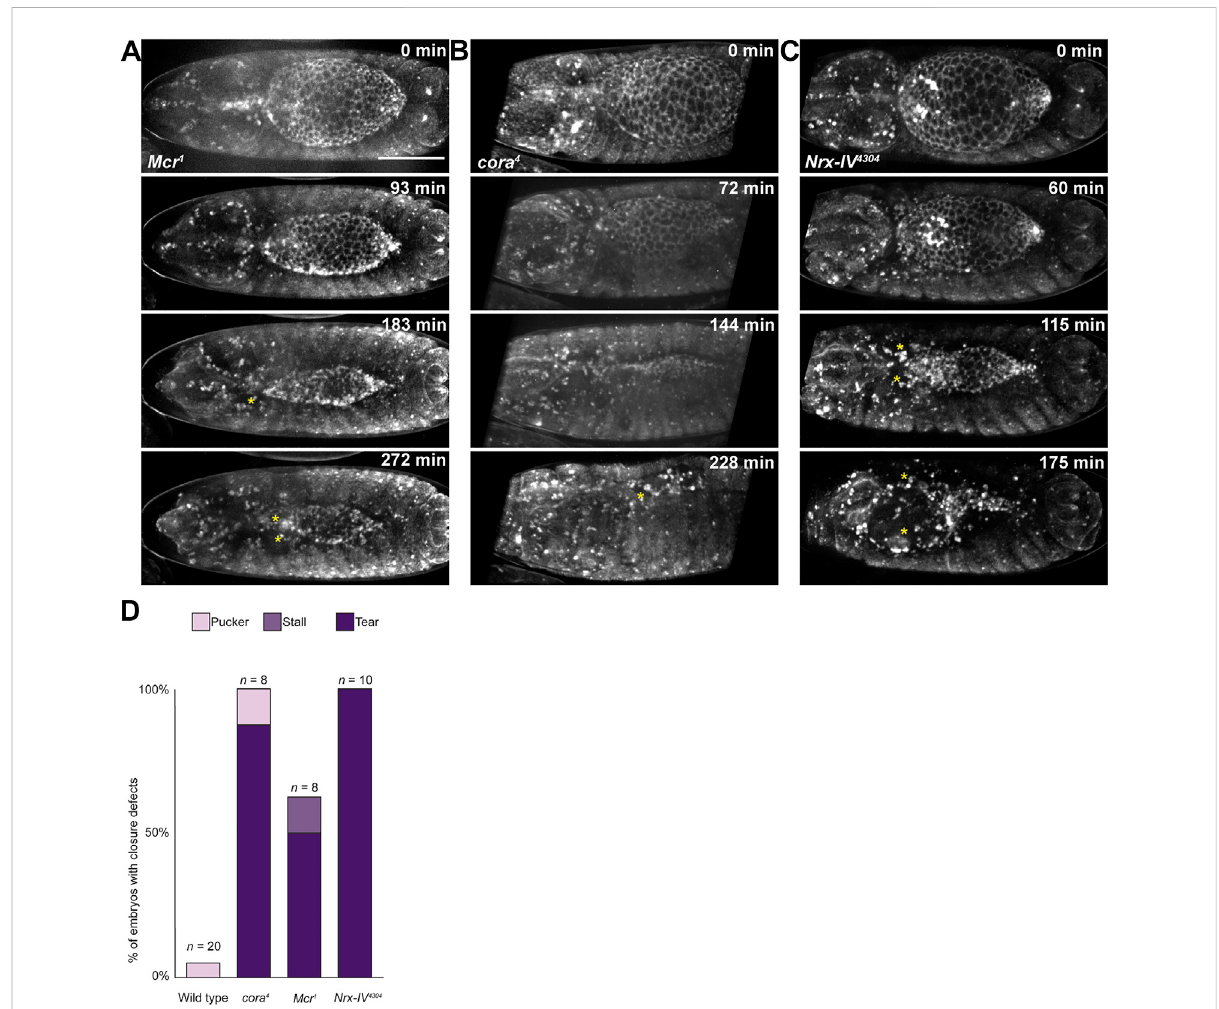
FIGURE 5 Late in DC, the epidermis tears away from the amnioserosa in SJ mutant embryos. (A – C) Still images from time lapse series of SJ mutant embryos during closure. Yellow stars indicate tears. (D) Observed frequency of closure defects in wild type and SJ mutant embryos. Scale bar = 100